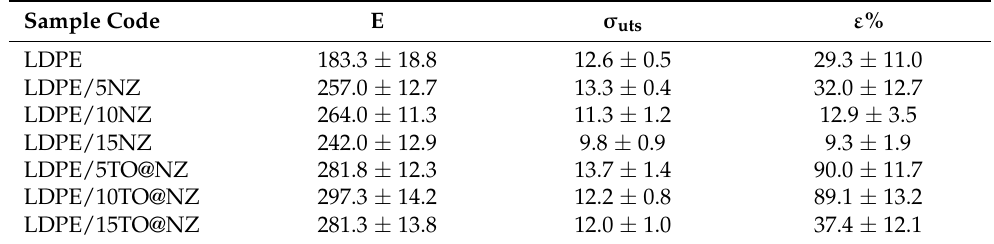
Table 2. Modulus of elasticity € , ultimate strength ( σ uts ), and elongation at break % ε values for pure LDPE film and for all LDPE/xNZ and LDPE/xTO@NZ